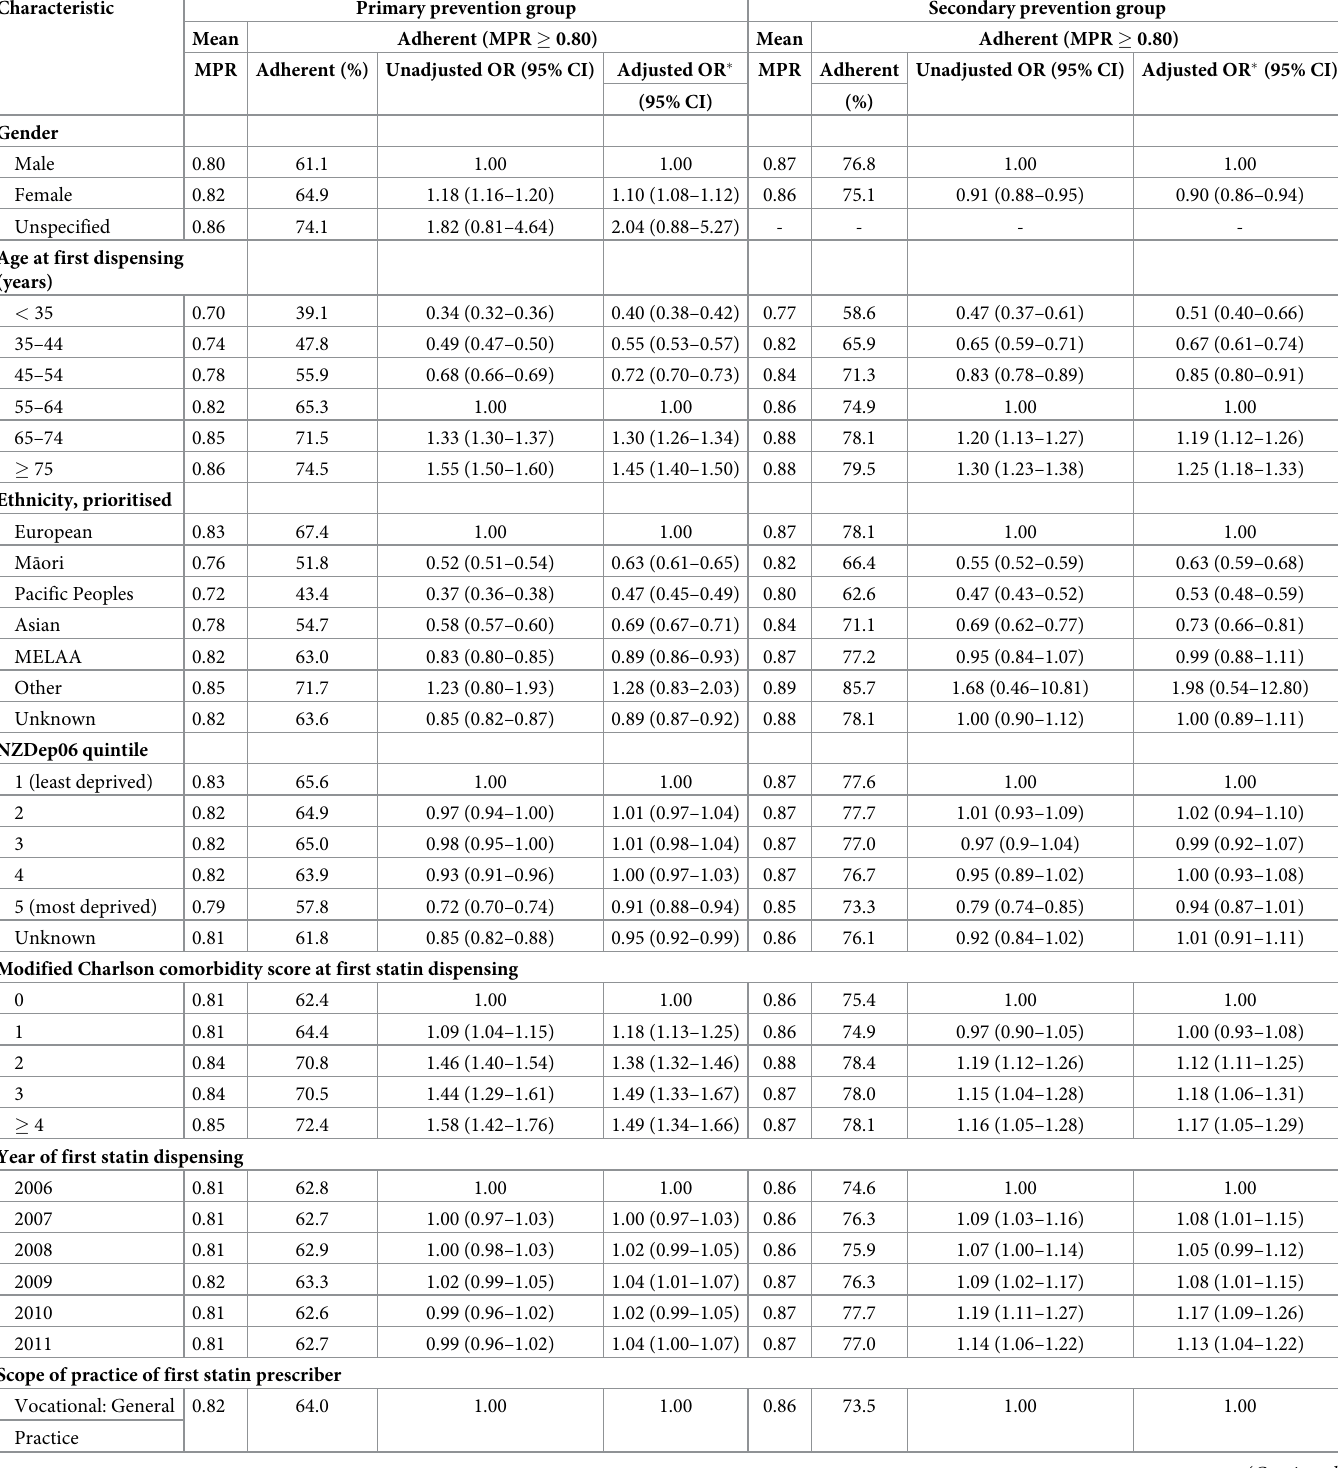
Table 3. Mean MPR and adherence in primary and secondary prevention groups in first year of follow-up, by patient characteristics.